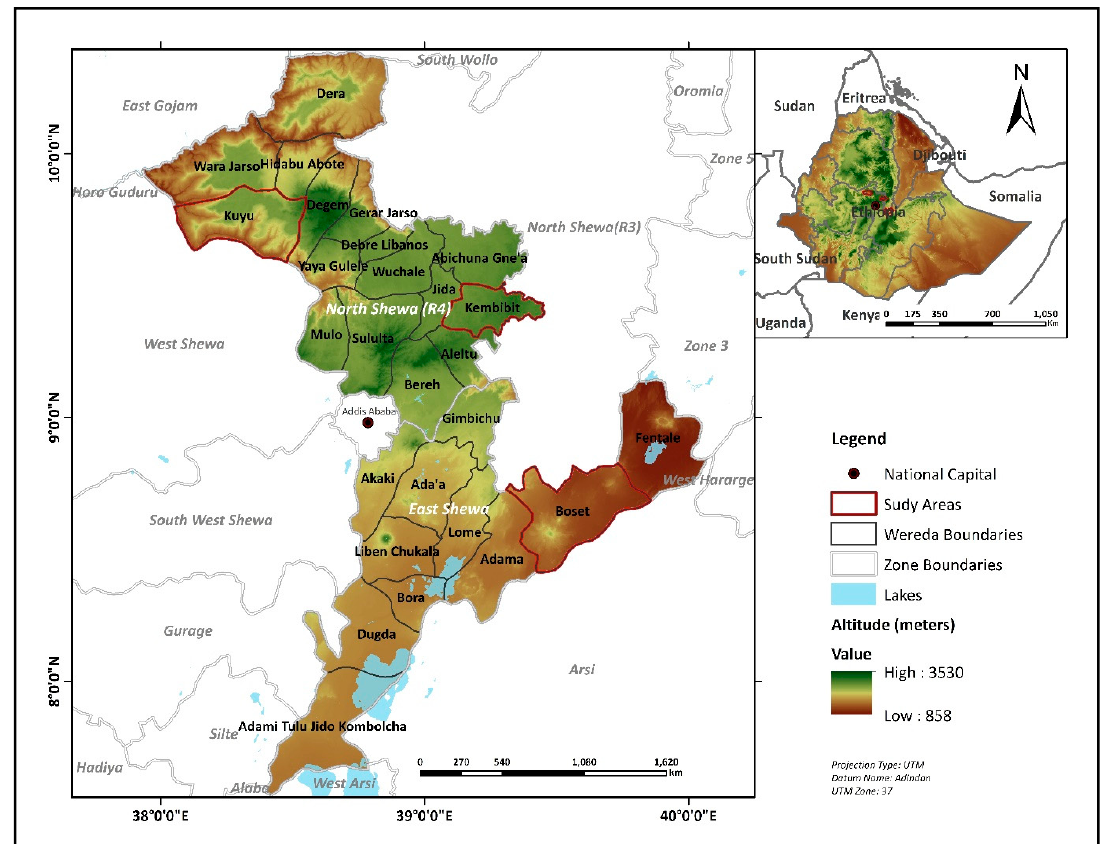
Figure 1. Geographical location and topography of the study areas.